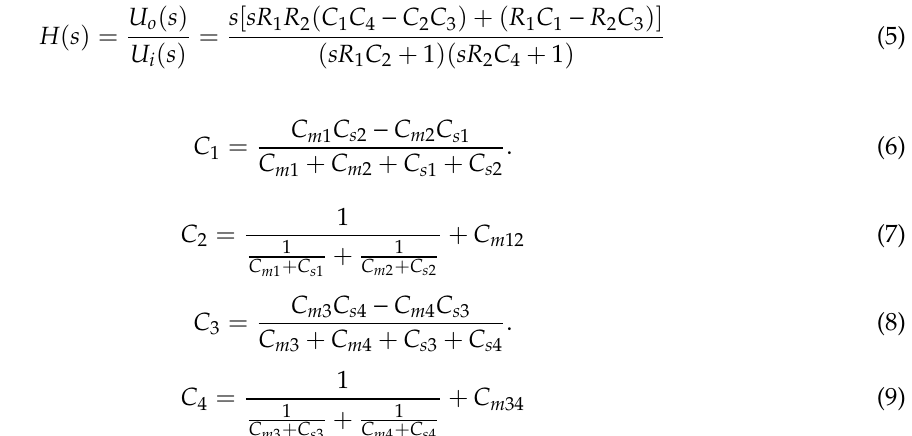
Figure 3. Equivalent circuit of the Dual-Differential D-dot overvoltage sensor.